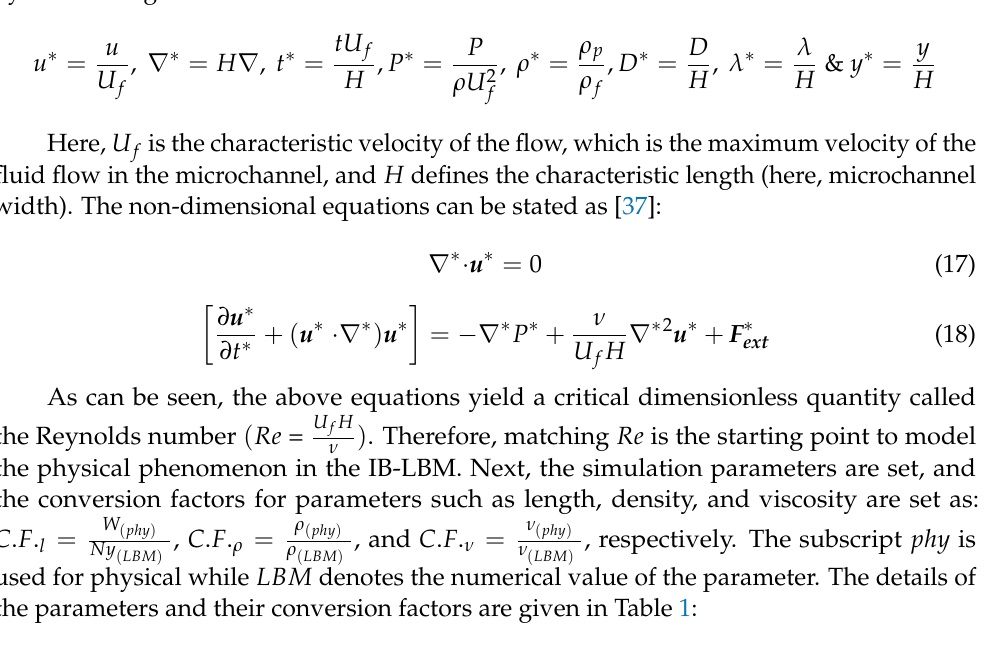
Table 1. Parameters used in the current work and their corresponding values in physical and LBM domains. Property Physical Domain ( phy ) LBM Domain ( LBM ) Conversion Factor (C.F.) Channel width, W 160 µ m 80 Water density, ρ f Particle density, ρ